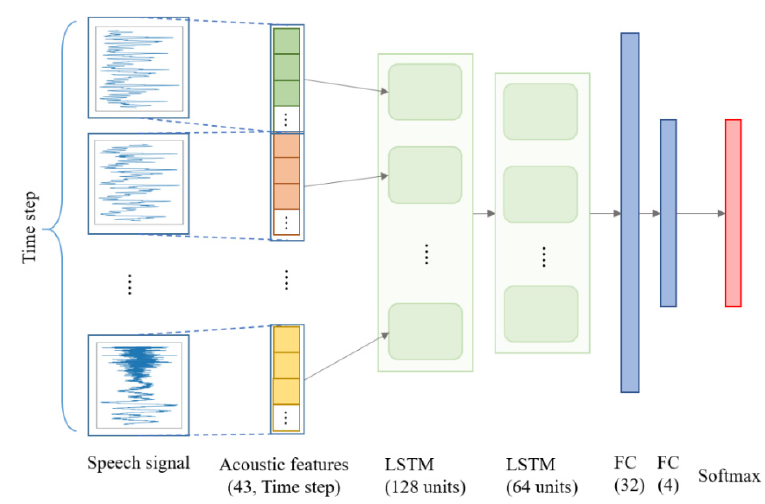
Figure 3. Structure of the model with acoustic features from speech data.